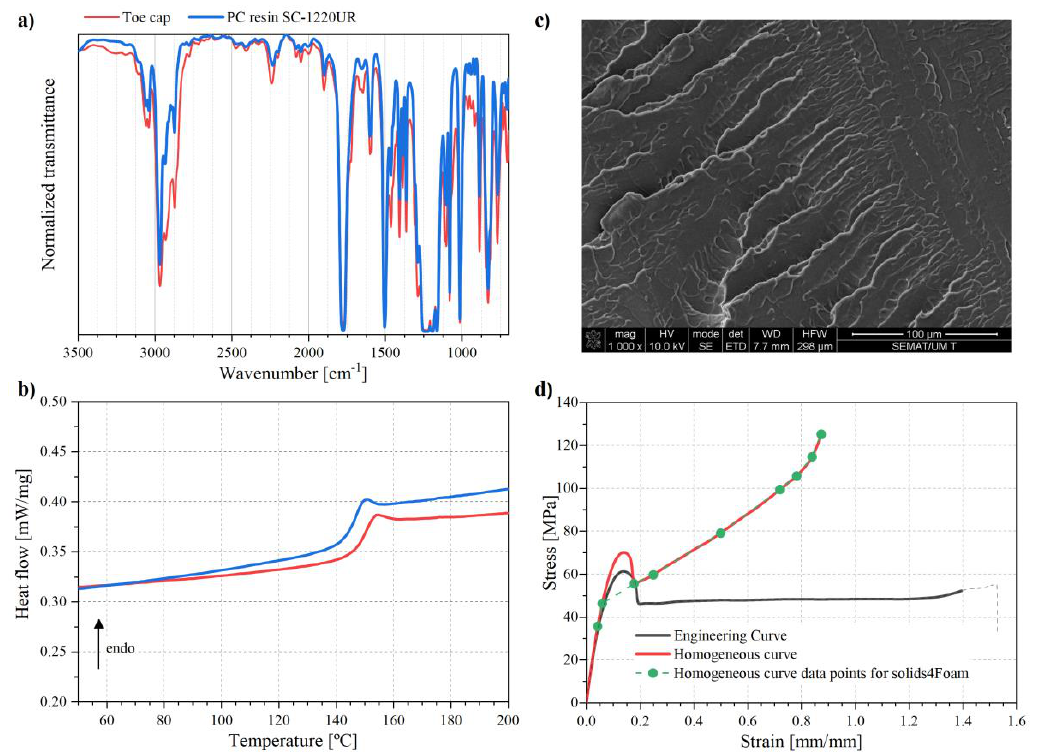
Figure 5. Toe cap material characterization: ( a ) FTIR spectrum, ( b ) DSC thermogram, ( c ) SEM image and ( d ) tensile test curve.